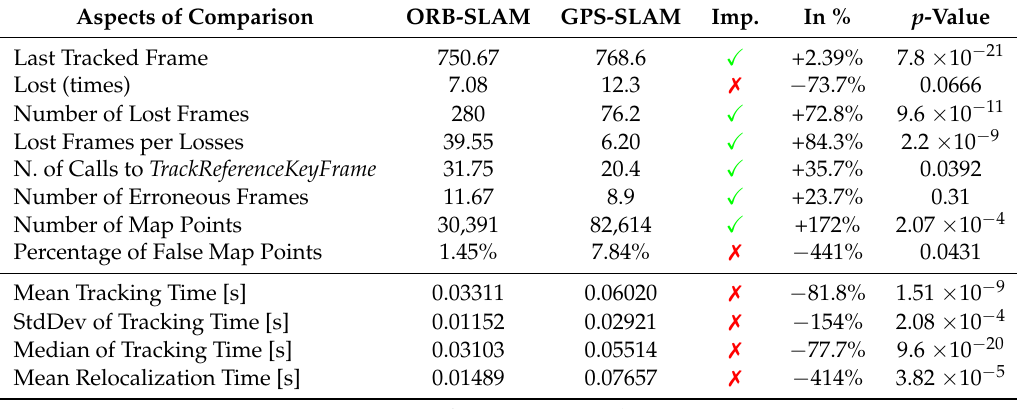
Table 1. The average of the extracted data from 10 runs of each algorithm made with 2000